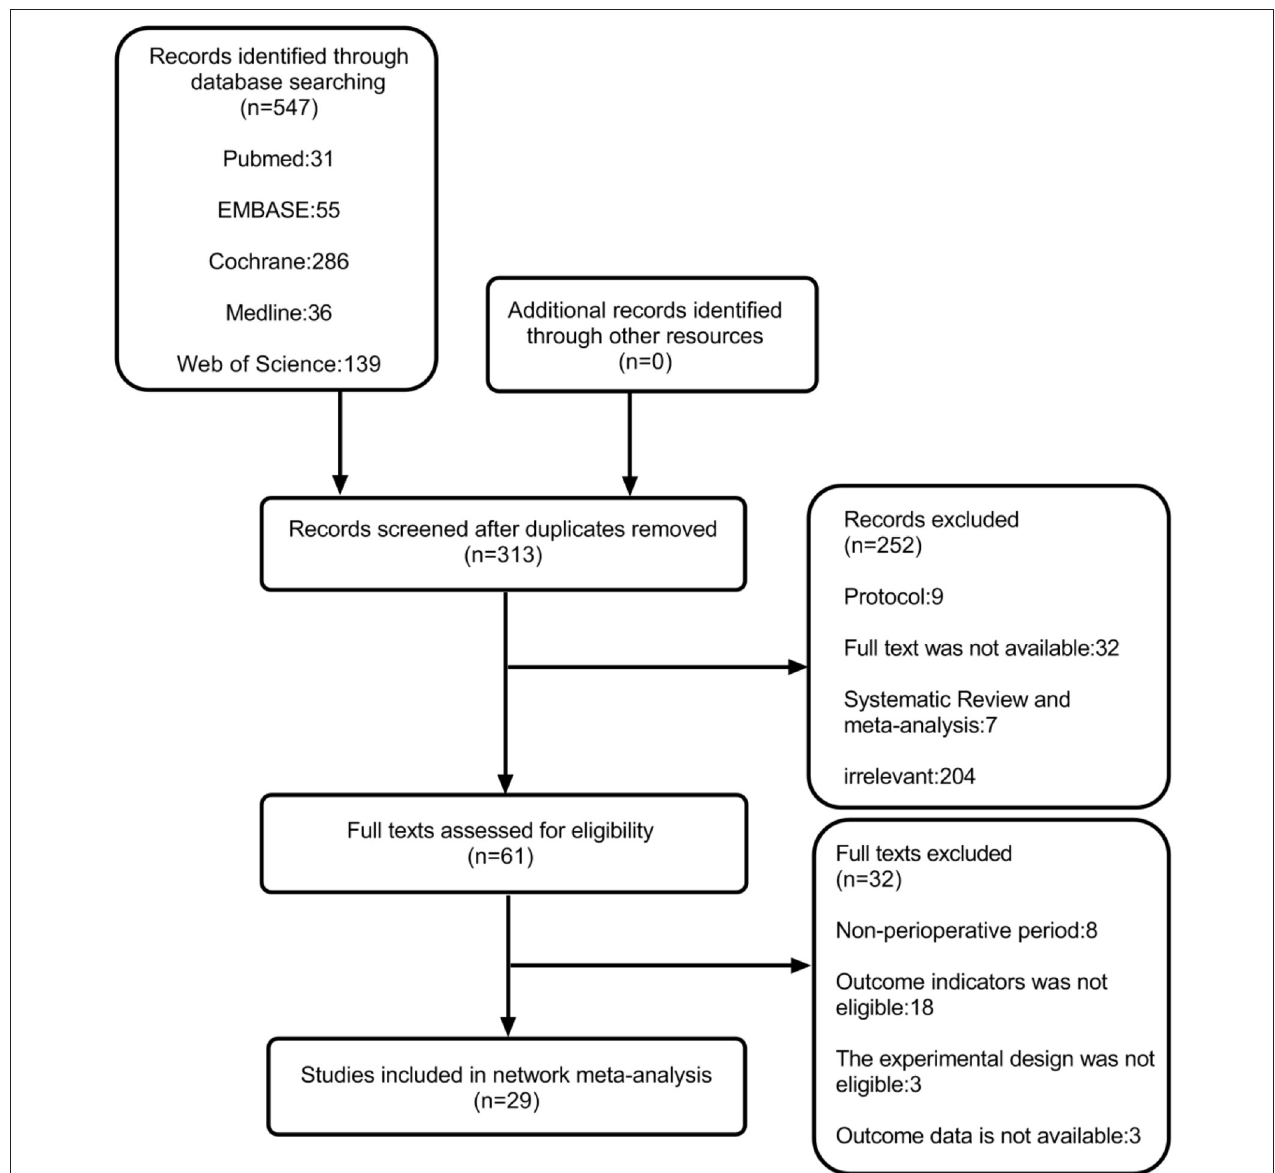
FIGURE 1 | PRISMA flowchart of study